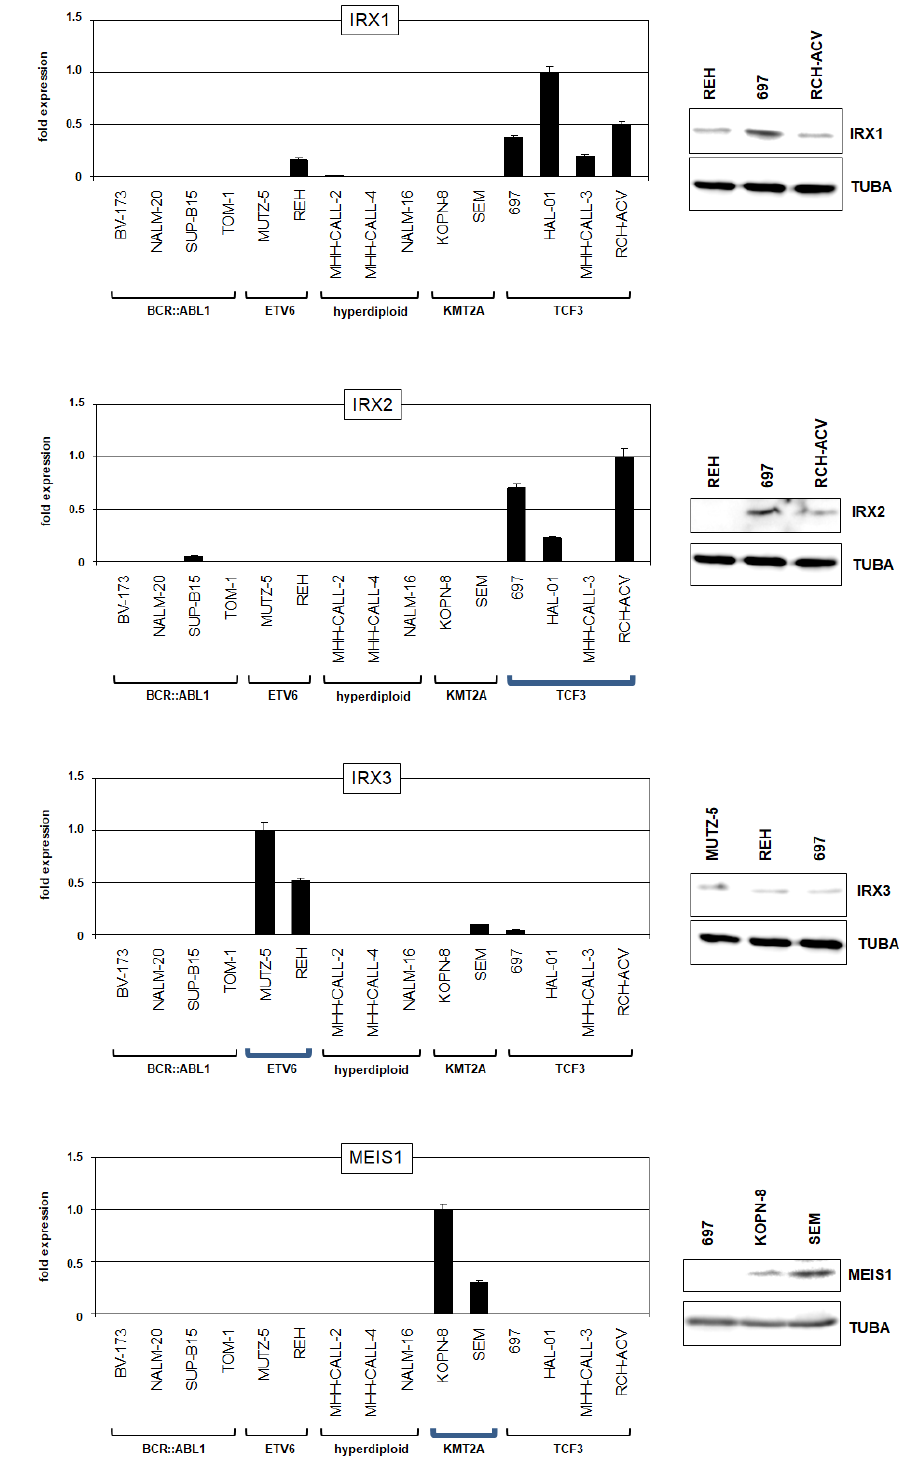
Figure 3. IRX and MEIS gene activities in BCP-ALL cell lines. Expression analyses of TALE homeobox genes IRX1, IRX2, IRX3 and MEIS1 in selected BCP-ALL cell lines as performed by RQ-PCR ( left ) and Western blot analyses ( right ). TUBA served as loading control. Cell lines were arranged according to reported subtypes as indicated below. Subtypes with corresponding gene activities detected in patients are highlighted by bold blue brackets. Of note, BCP-ALL cell line MUTZ-5 aberrantly expressed IRX3 but was negative for fusion gene ETV6::RUNX1 (Figure S5). RT-PCR analysis showed a rather complete